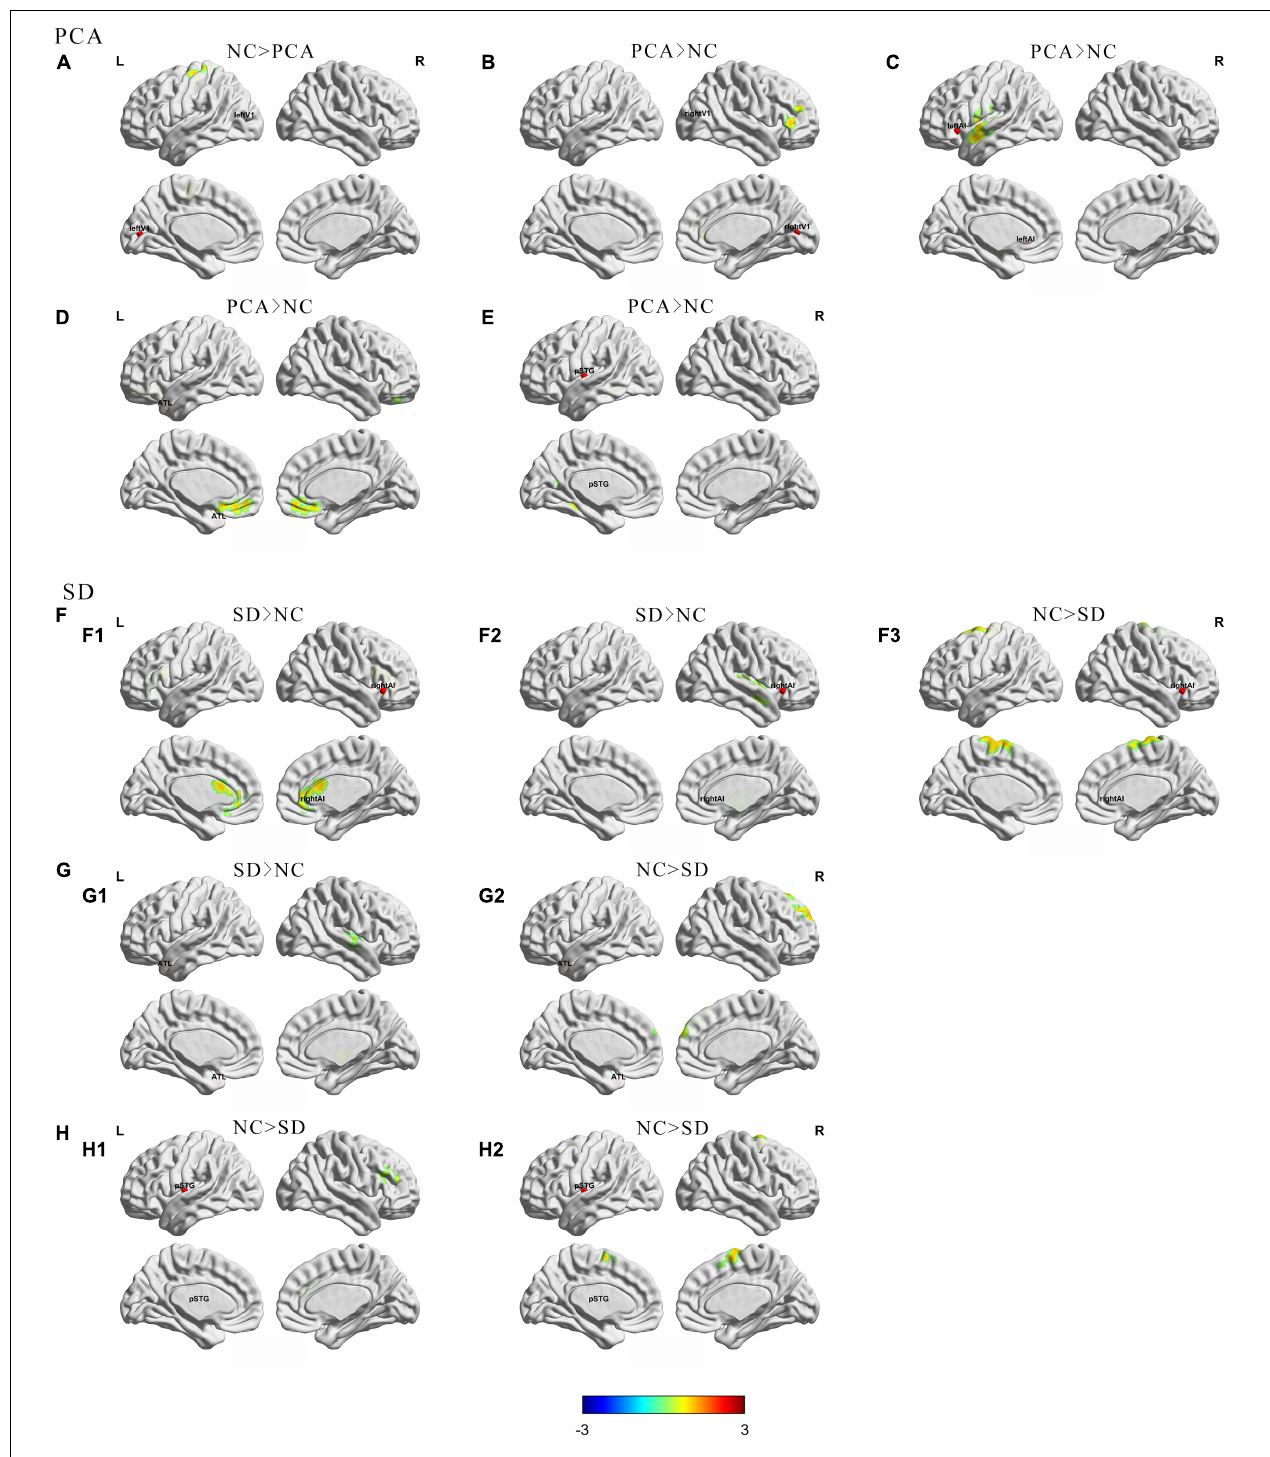
FIGURE 1 | Group differences in regional functional connectivity from seed between patients (PCA or SD) and controls. The results were mapped on the brain surface using BrainNet Viewer (Xia et al., 2013) showing reduced or increased regional functional connectivity from seeds (A) left V1; (B) right V1; (C) left anterior insula; (D,G) left anterior temporal lobe; (F) right anterior insula; (E,H) left superior temporal gyrus) in PCA compared with NC (A–E) or SD (F–H) compared with NC (two-sample t -test, voxel level p < 0.005, cluster level p < 0.05, GRF corrected). The red spheres were localizations of seeds. Colors indicate t scores. ATL, anterior temporal lobe; pSTG, post-superior temporal gyrus; AI, anterior